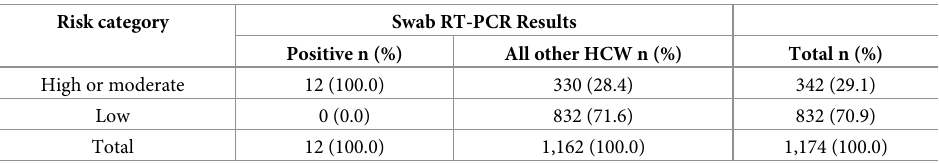
Table 4. Cross-tabulation of risk category and RT-PCR results (n =